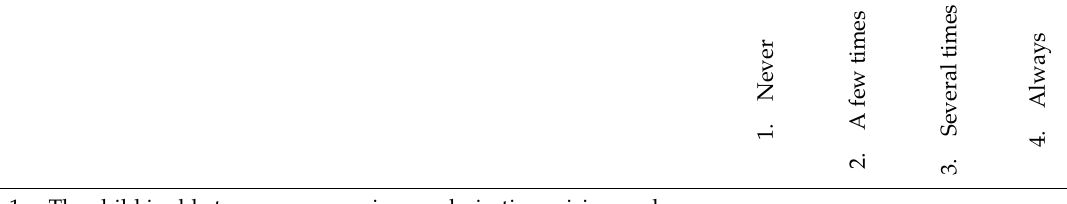
Table 3. Scale of facial movements evaluation of children with Cerebral Palsy.